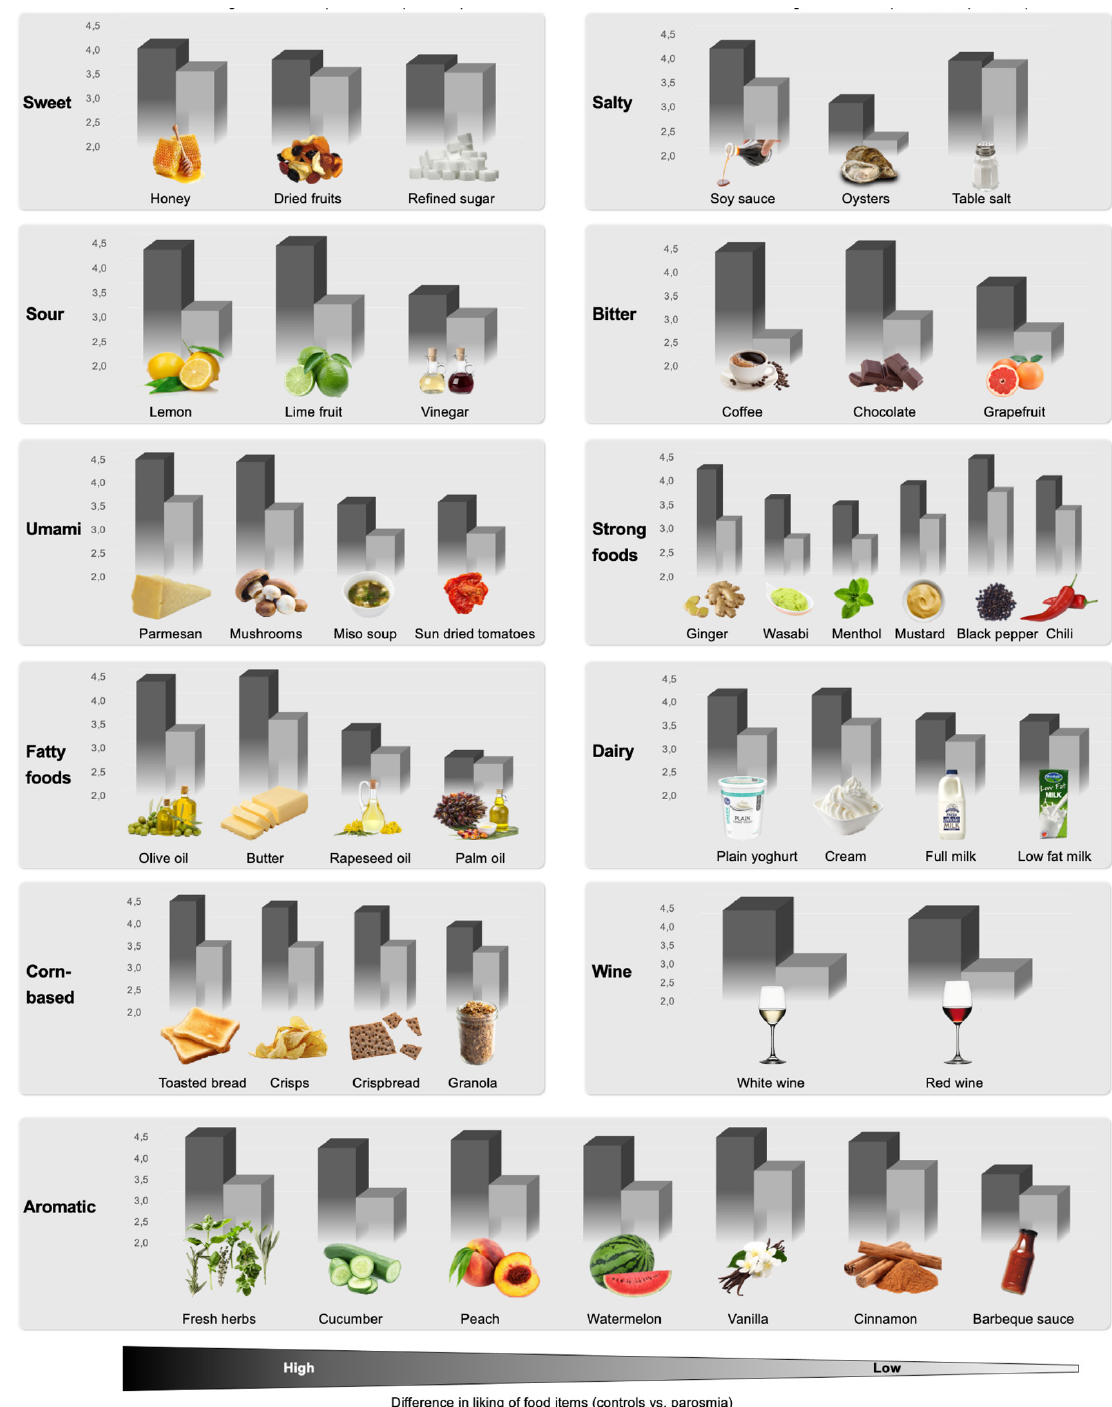
Figure 5. Liking of food items in parosmia (grey) compared with normosmic controls (black). For all food items categories (basic tastes, fatty, dairy, corn-based, wine, and aromatic foods) food items are listed from left to right according to the difference in liking between normosmic controls and parosmic participants (high to low difference). When choosing ingredients, food items on the right side of each category are more similar in liking between parosmic participants and normosmic controls. This may indicate ‘safer foods’, however, please see Table 3, as some items are rated lower in the frequency of intake, which may influence ratings of